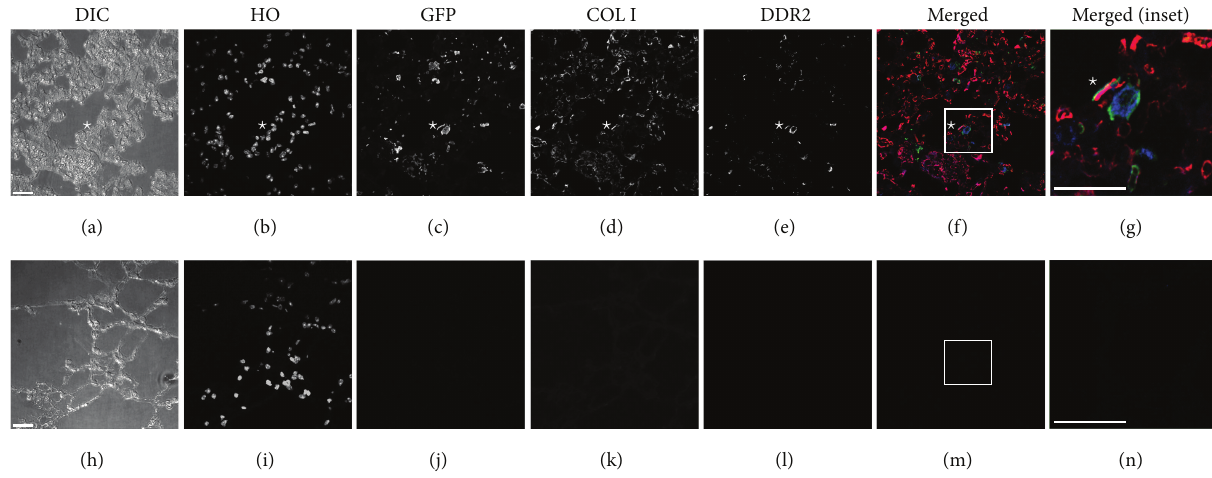
Figure 6: Hematopoietic stem cells give rise to lung fibroblasts in vivo . Differential interference contrast (DIC), Hoechst nuclear stain (HO), EGFP, Collagen I, and DDR2 antibody stain are shown in Panels (a)–(e), respectively, from a representative section of lung tissue from a clonally engrafted mouse. Panel (f) shows merged image of GFP (green), Collagen I (red), and DDR2 (blue) staining. Panel (g) shows higher magnification of inset (boxed area) in Panel (f) with * indicating a GFP/Collagen I/DDR2 expressing cell. Panels (h)–(n) depict images from secondary only staining